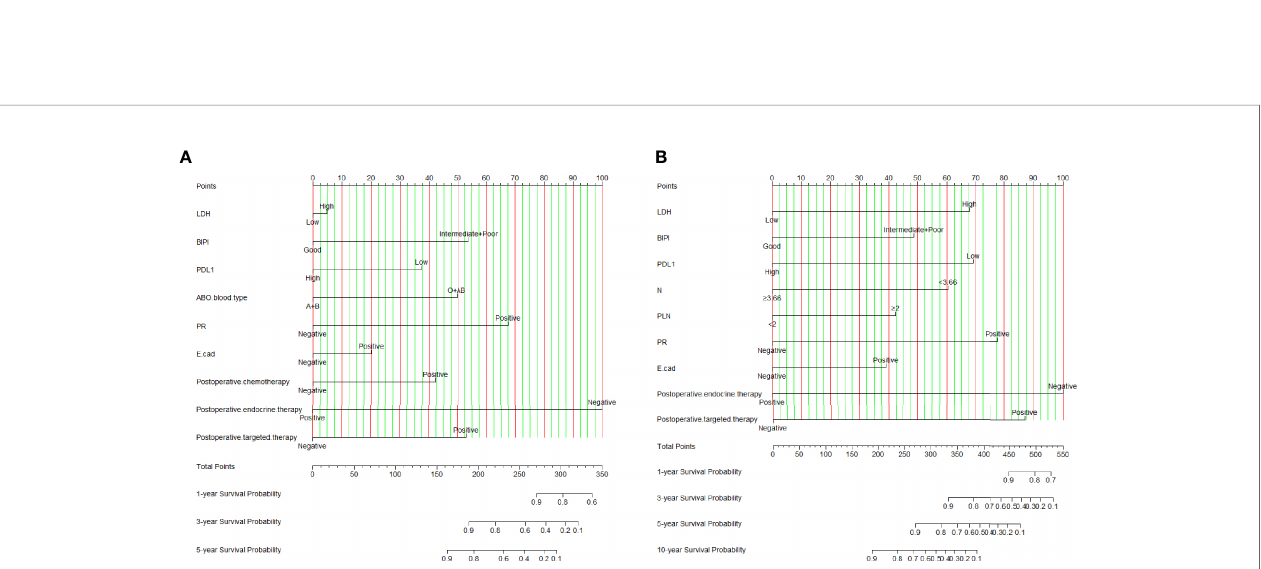
FIGURE 2 | Breast immune prognostic index (BIPI)-based nomogram for predicting disease-free survival (DFS) and overall survival (OS). A straight upward line is drawn to determine the points for every predictor. The sum of these points is situated on the total points axis, and a straight downward line shows the 1-, 3-, and 5- year DFS estimated rates and 1-, 3-, 5-, and 10-year OS estimated rates. (A) BIPI-based nomogram for predicting disease-free survival (DFS). (B) BIPI-based nomogram for predicting and overall survival (OS). E-cad, E-cadherin; N, neutrophils; PLN, positive axillary lymph